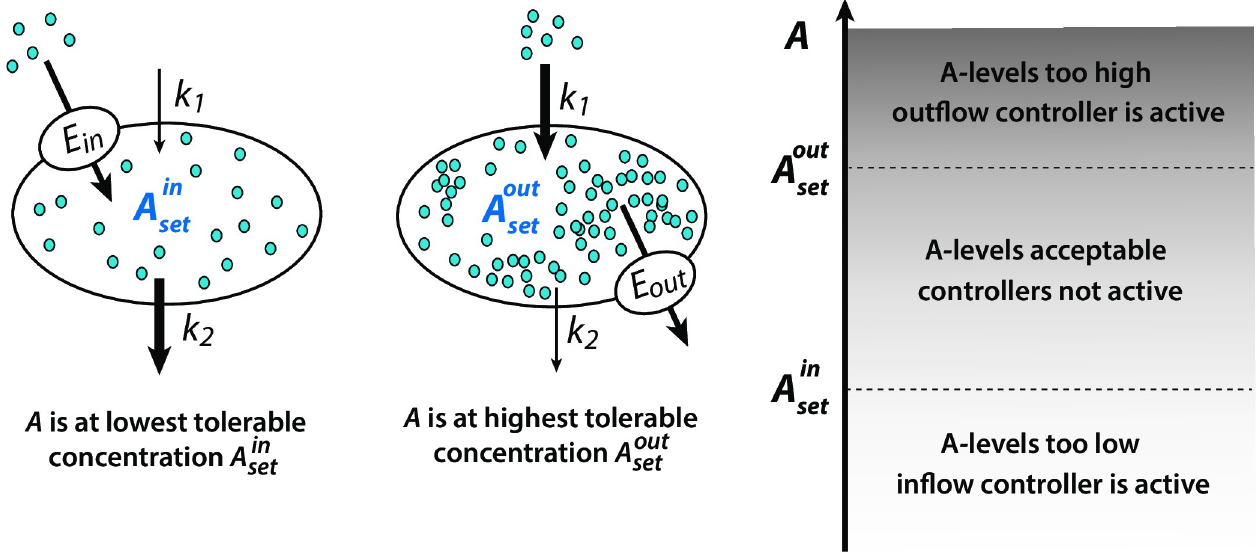
and E ) which keep a controlled variable A within the controllers’ in out